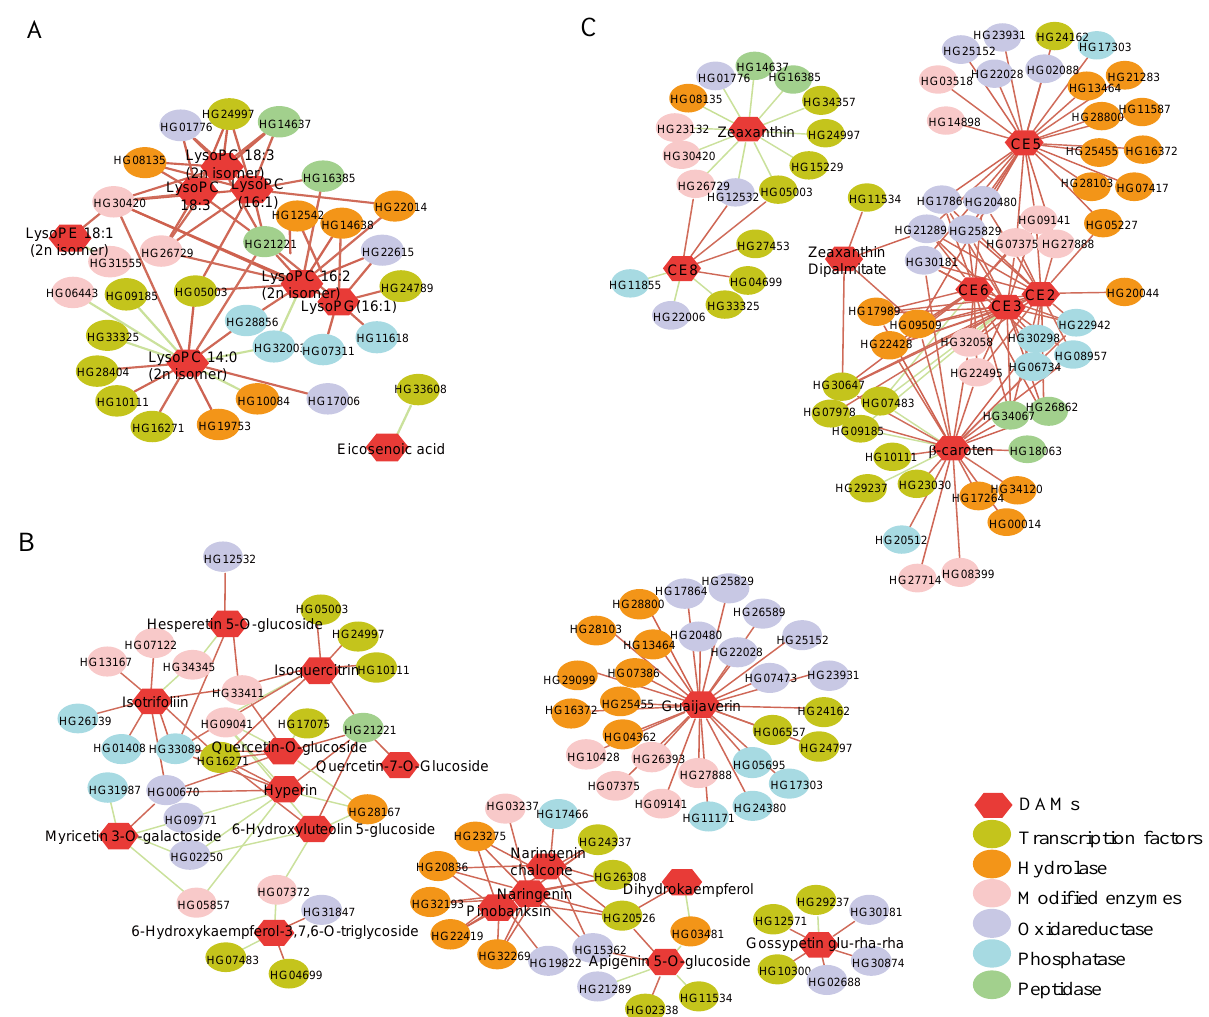
Figure 3. The co-expression network of differentially expressed genes (DEGs) and accumulated metabolites (DAMs) involved in lipid ( A ), flavonoid ( B ) and carotenoid ( C ) pathways. The red hexagons represent differentially accumulated lipids, flavonoids and carotenoids; the ellipses with different colors represent DEGs belonging to different modules in Figure S8. All correlations with p < 0.05 and |PCC| > 0.9 were included. The red edges indicate a positive relationship between nodes while green edges suggest negative relationships.